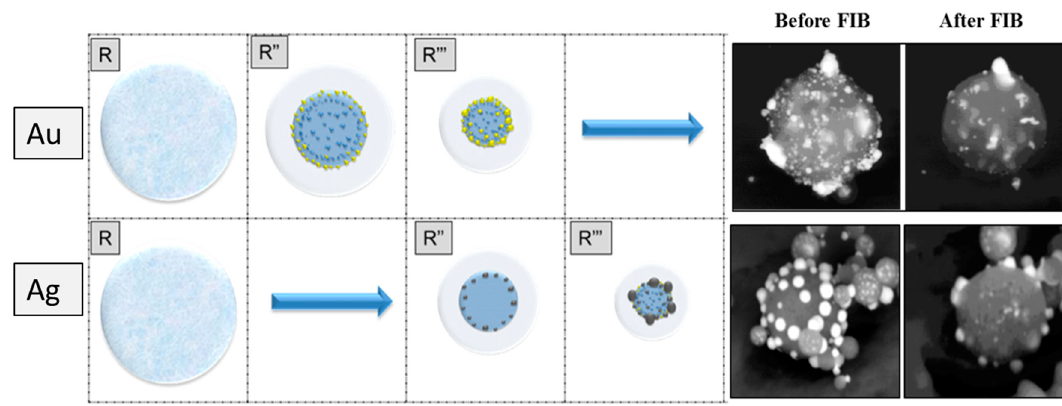
Figure 6. Schematic representation of the proposed new model for metal/oxide nanoparticle formation, applied on Ag/TiO 2 and Au/TiO 2 nanoparticles with the examples of the microstructural analyses confirmed before and after FIB milling [20].